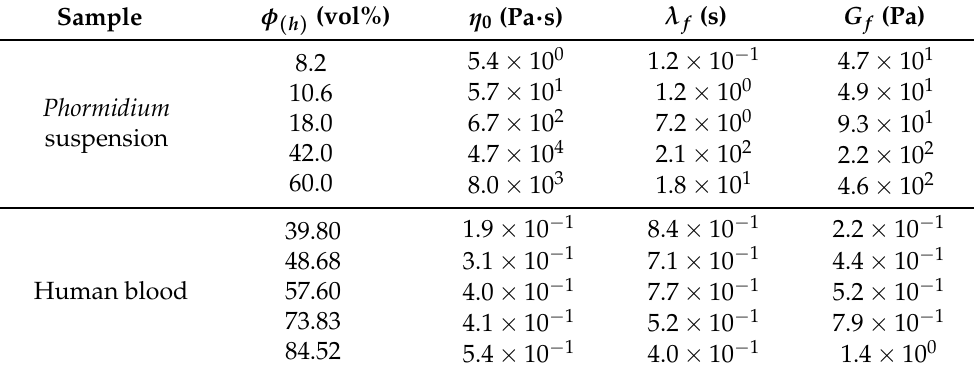
Table 2. The zero-shear viscosity, the mean characteristic time and the mean modulus estimated from the fitted master curves of Phormidium suspension and human blood with respect to various reference volume